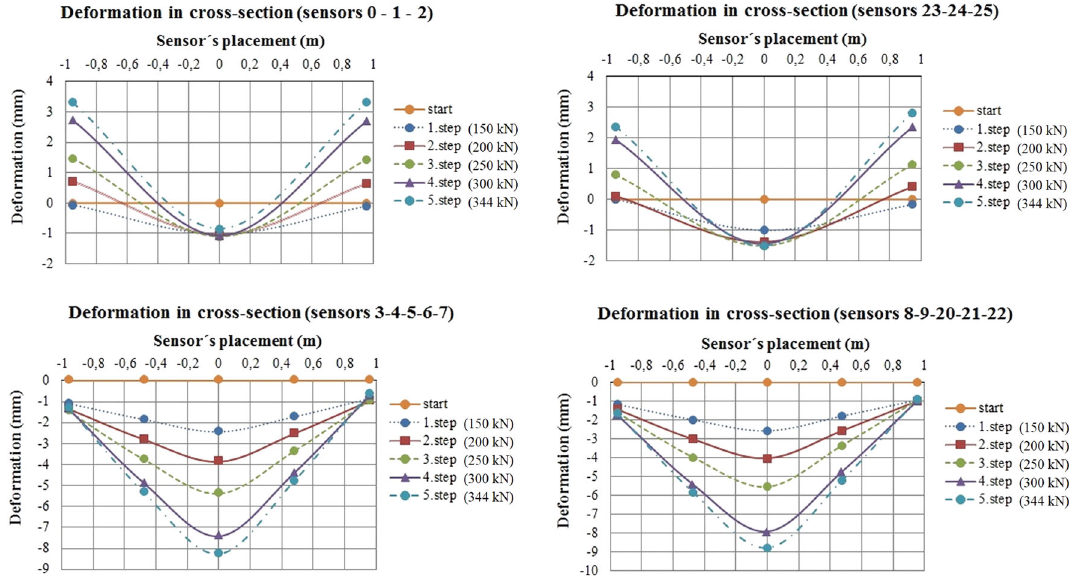
Fig. 5 Vertical deformation of the slab—in cross-sections (mm).